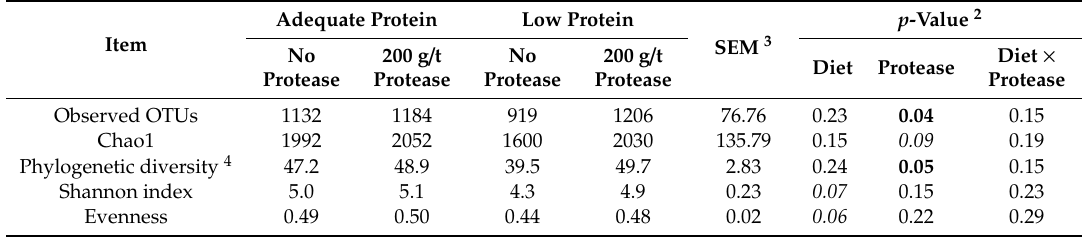
Table 4. E ff ect of diet 1 and protease on α diversity indices at 97% similarity after rarefaction to 56,855 sequences per